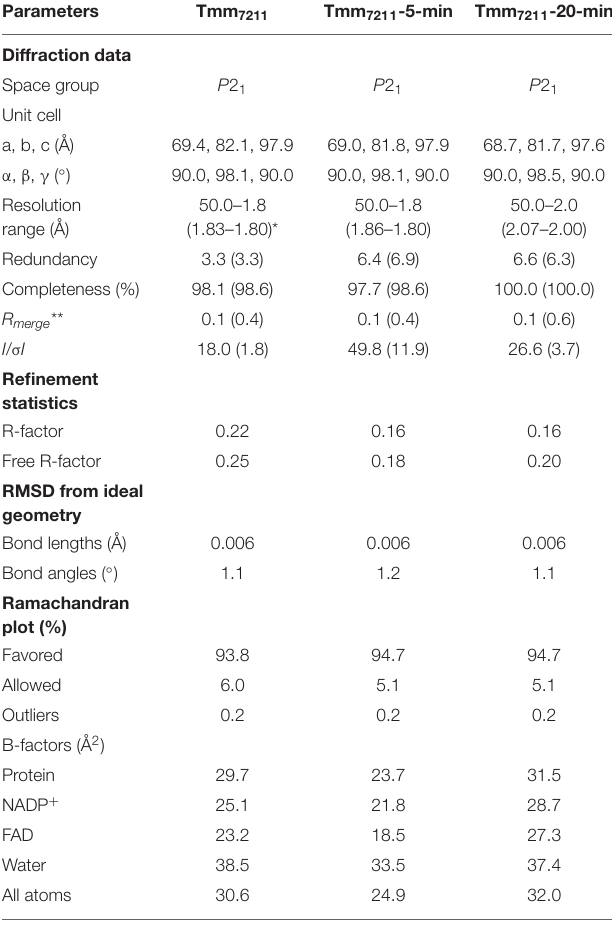
TABLE 2 | Crystallographic data collection and refinement of Tmm 7211